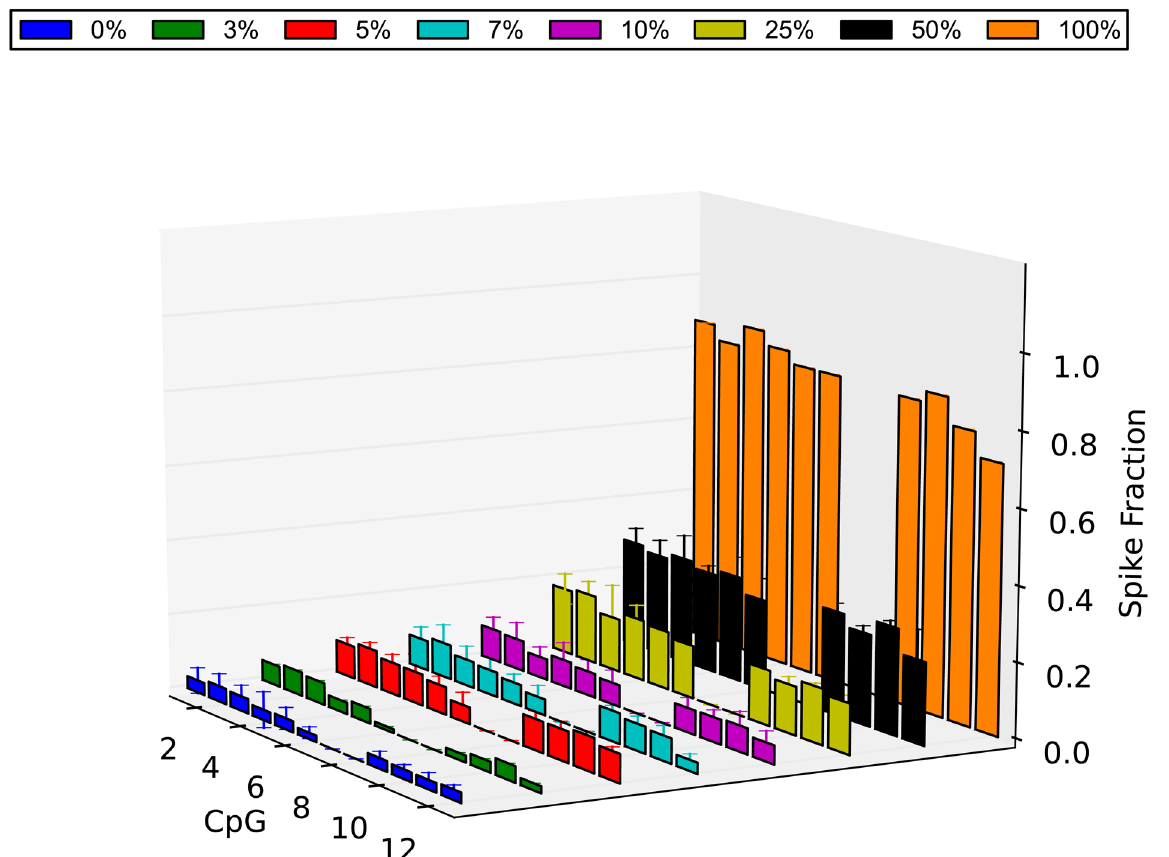
Fig 9. Methylation level of the EP10 DMR as determined by NGS. The methylation level of all the CpG sites of the amplified region of the EP10 DMR is plotted for all the spikes. Shown is the average value of each CpG in each spike as was calculated from 3 technical replicates (CVS 0% = blue, 3% = green, 5% = red, 7% = light blue, 10% = purple, 25% = yellow, 50% = black, 100% = orange). In order to calculate statistical significance of the methylation level of each spike, we created a dataset of average performance for each spike group and we compared these average performance datasets with the 0% CVS average performance set using a t-test. It was demonstrated that the small spikes showed significantly higher methylation levels than the 0% CVS group [5% (P = 7.239e-09), 7% (P = 6.612e-06), 10% (P = 1.068e-07)]. Errors bars = SD